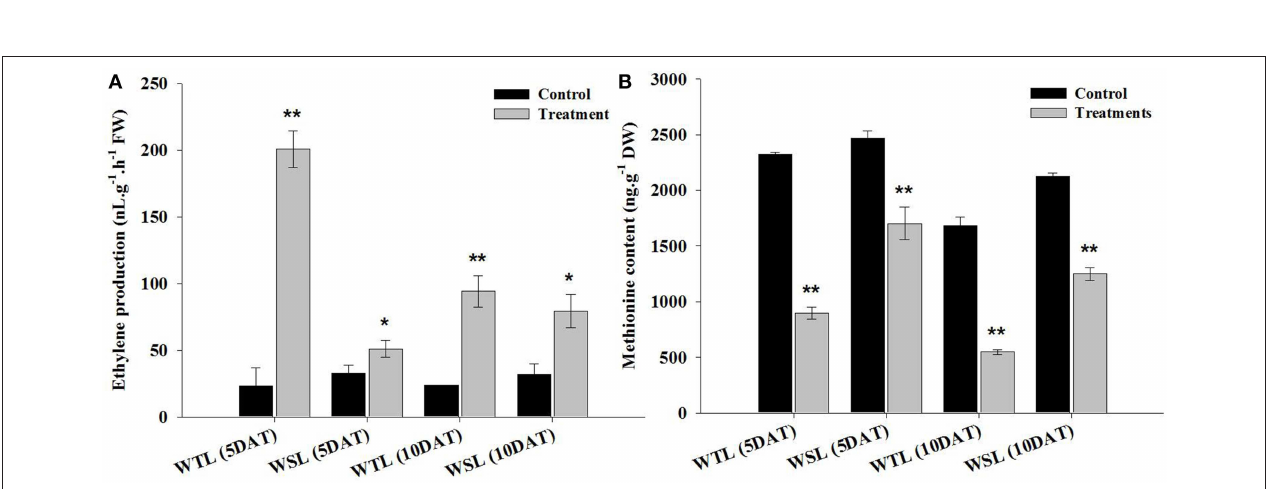
FIGURE 1 | Number of adventitious root and images of adventitious roots at 5 and 10 days after waterlogging stress. In the figure, (A) indicates the number of adventitious roots and WTL indicates the waterlogging tolerant line (PI408105A), and WSL indicates the waterlogging susceptible line (S99-2281). (B–E) Indicate the images of adventitious roots and in each picture, the control plant is on the left, and waterlogging treated plant on the right. In (A) , star marks indicate a significant difference between control and treatment at P < 0 . 05 or P < 0 . 01 . Data show average ± standard error ( n = 20 ) and was collected over three replications.